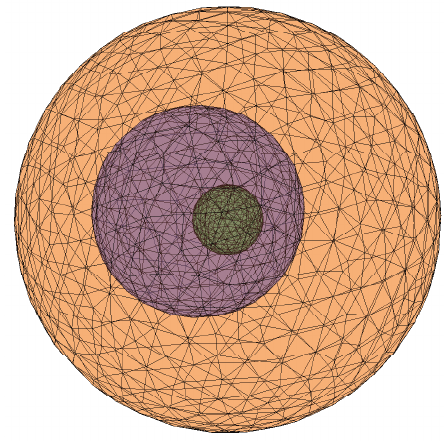
Figure 9. Horizontal electric dipole in sphere structure. External sphere: Yellow. Middle sphere: Purple. Internal sphere: